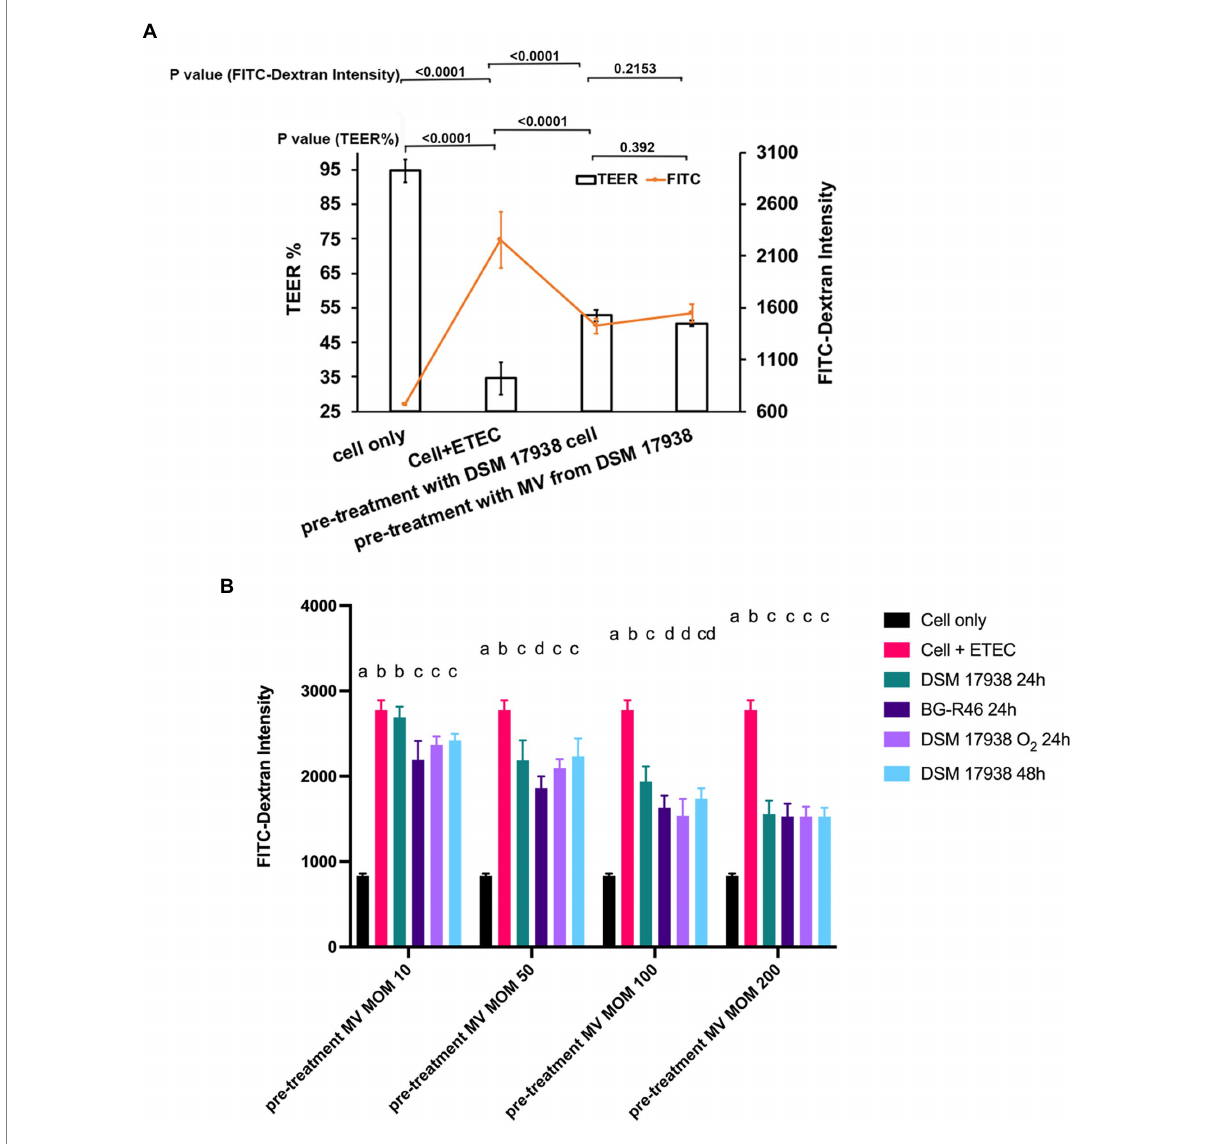
FIGURE 5 Effect of L. reuteri derived MV on the barrier integrity of monolayers treated with ETEC. The Caco-2/HT29-MTX co-cultures were grown on transwell filters for 21 days. (A) Polarized monolayers with/without pre-treatment of L. reuteri DSM 17938 bacteria cells and derived MV at multiplicity of bacteria/MV of 100:1 and 200:1 for 6 h. After 6 h pre-treatment, the monolayer was infected with ETEC at multiplicity of infection (MOI) 100 for 6 h. TEER was measured in ohms and corrected for the resistance of the blank filters and for the membrane area and expressed as percentage of the starting value (before pre-treatment with MV). The fluorescence intensity is from the fluorescein isothiocyanate (FITC)-dextran which was detected from the basolateral pole. Data are given as means of six independent seedings. Statistical analysis by one-way analysis of variance (ANOVA), p < 0.05. (B) Polarized monolayers with/without pre-treatment of MV which were isolated from L. reuteri under different cultivation conditions. The fluorescence intensity is from the FITC-dextran which was detected from basolateral pole of each sample. Columns with different letters are significantly different ( p <0.05).. Statistical analysis by two-way ANOVA. Error bars are SD ( n =